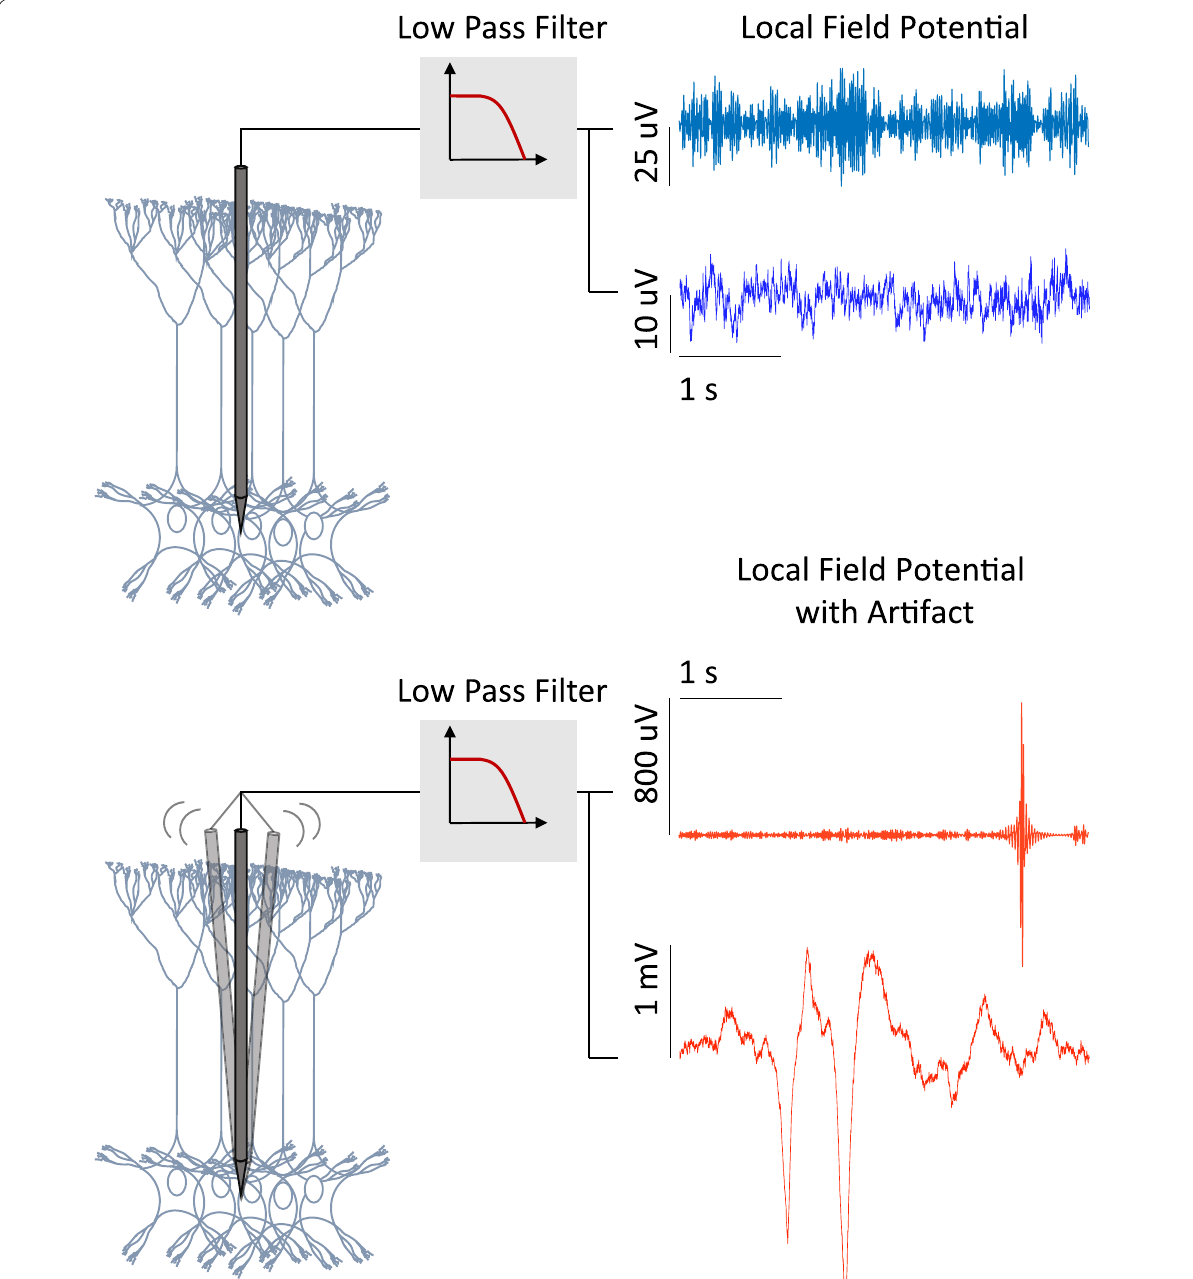
Fig. 2 Recording of extracellular neuronal signals from behaving rodents using linear implantable neural probe (shown in gray). Representative local field potential signals with and without movement artifacts are shown from two datasets. The blue traces denote signals without artifacts and the red traces show examples of movement artifacts present in the